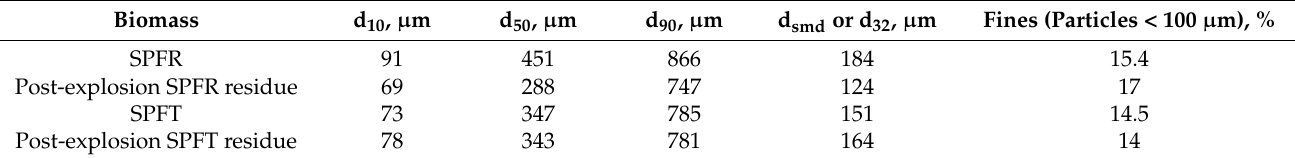
Table 2. Size distribution in µ m of the raw and torrefied biomass (SPFR—Spruce-Pine-Fir Raw biomass; SPFR—Spruce-Pine-Fir after